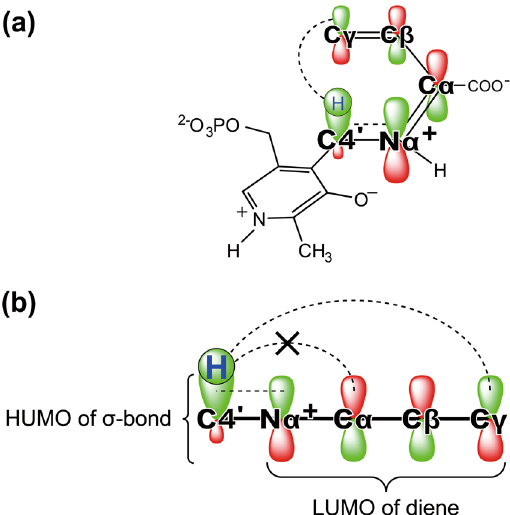
Figure 4. The suprafacial [1,5]-hydrogen shift in a conjugated ene-imine system of PMP-bound butenoate. ( a ) The migration of a hydrogen atom at C4 ′ to N α and C γ is indicated by dashed lines. ( b ) Schematic diagram of the migration of a hydrogen atom. The [1,3]-hydrogen shift from C4 ′ to C α is symmetry